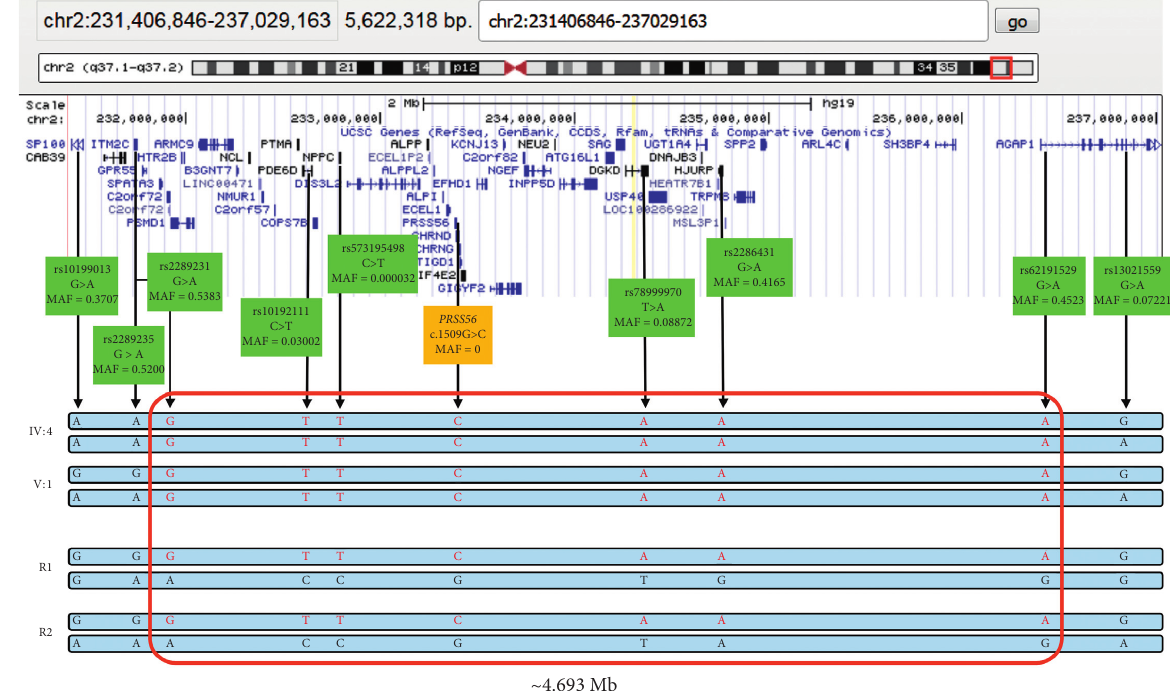
Figure 4: Putative ancestral chromosomal segment around the PRSS56 c.1509G > C variant. The single nucleotide polymorphism (SNP) database reference SNP (rs) ID of each variant and its minor allele frequency (MAF) mined from gnomAD database v2.1.1. are shown. SNPs in linkage disequilibrium with the disease-causing variant in PRSS56 as observed in two affected individuals (IV:4 and V:1) are highlighted in red. These SNPs were also found in two other reportedly unrelated Czech Roma subjects (R1 and R2), heterozygous carriers of the PRSS56 variant, indicating putative shared chromosomal segment with minimal interval delineated by two low frequent SNPs, rs10192111 and rs78999970 (size ∼ 1.65Mb). The region possibly extends up to variants rs2289231 and rs62191529 (size ∼